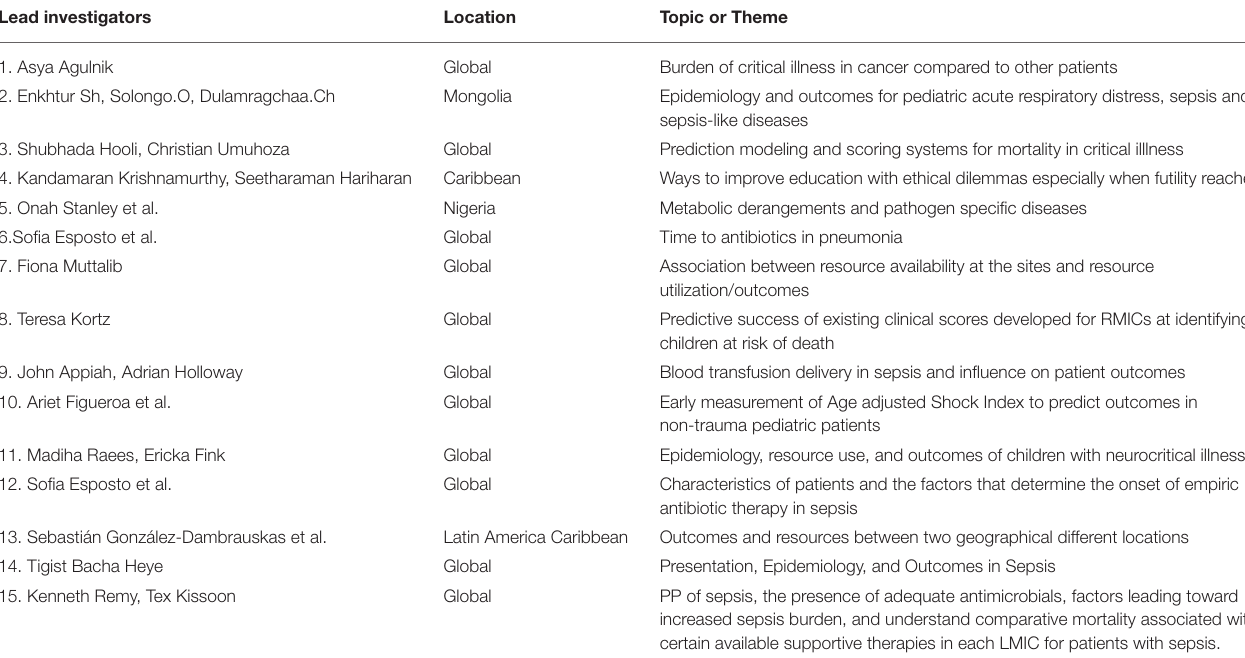
TABLE 2 | Global parity secondary